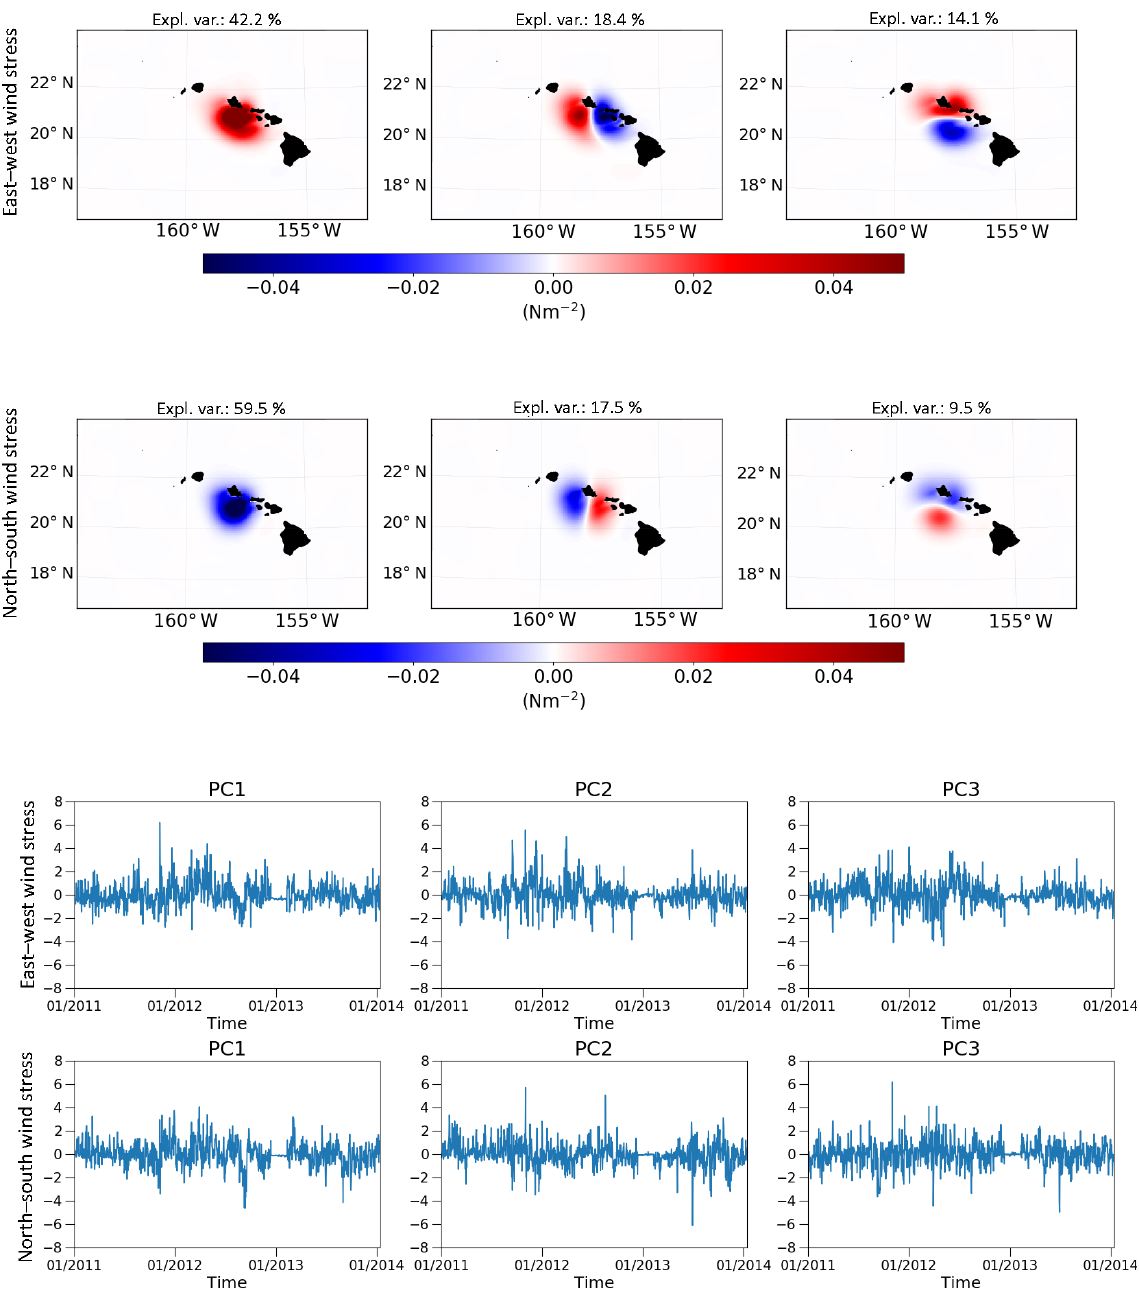
Figure 15. Spatial EOF patterns and principal components (PCs) of wind stress perturbations for the period including the assimilation of HFR measurements (January 2011–January